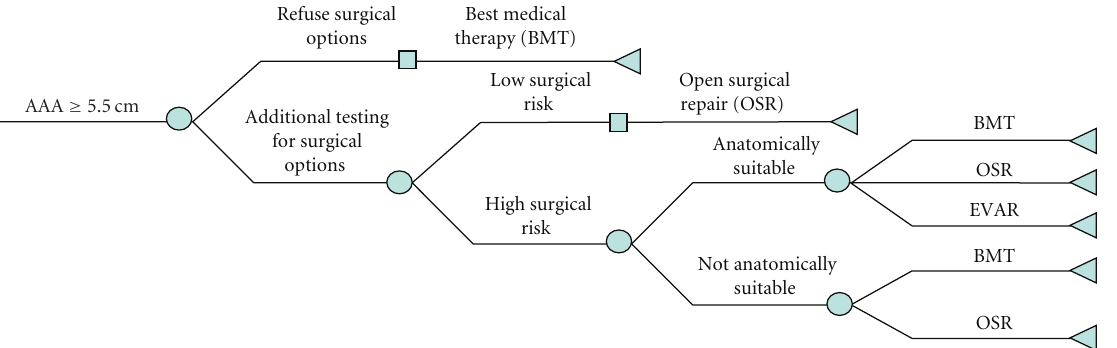
Figure 1: Treatment algorithm for elective